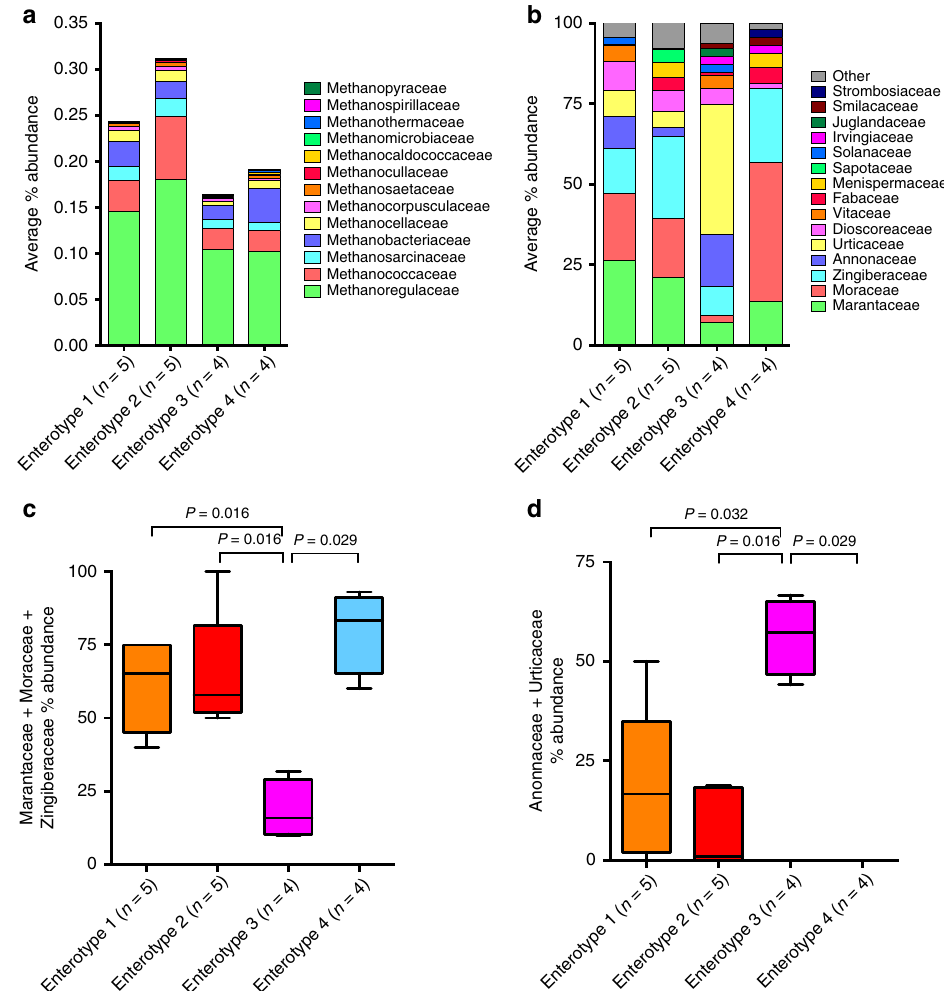
Fig. 9 Shotgun metagenomic sequencing reveals differences in methanogenic archaea and fecal dietary plant taxa among WLG enterotypes. Stacked bar charts showing the average percent abundance of a methanogenic archaeal families (identi fi ed by MetaPhlAn2) and b plant families (identi fi ed by a plant marker gene approach) in each WLG enterotype. c , d Box-and-whiskers plots showing the distribution of cumulative plant family percent abundance in each of the WLG enterotypes. Two-tailed P- values from Mann – Whitney tests are indicated in c ,